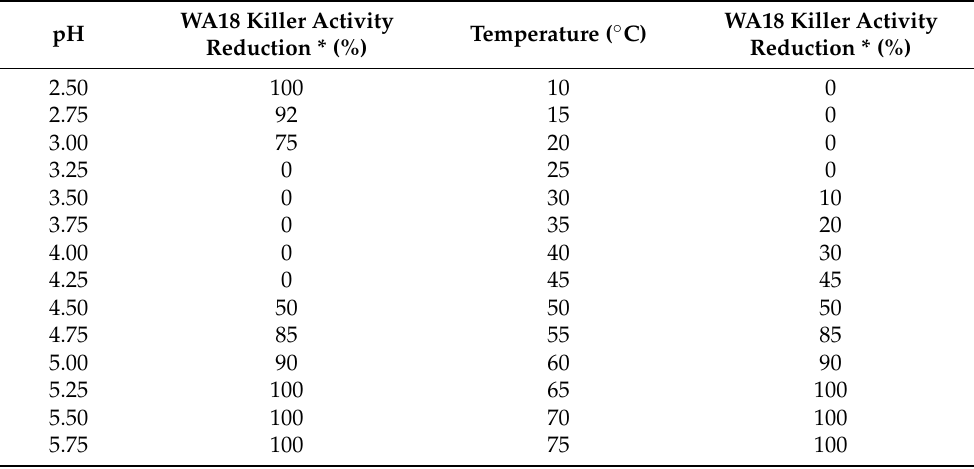
Table 3. Influence of pH and temperature on WA18 killer